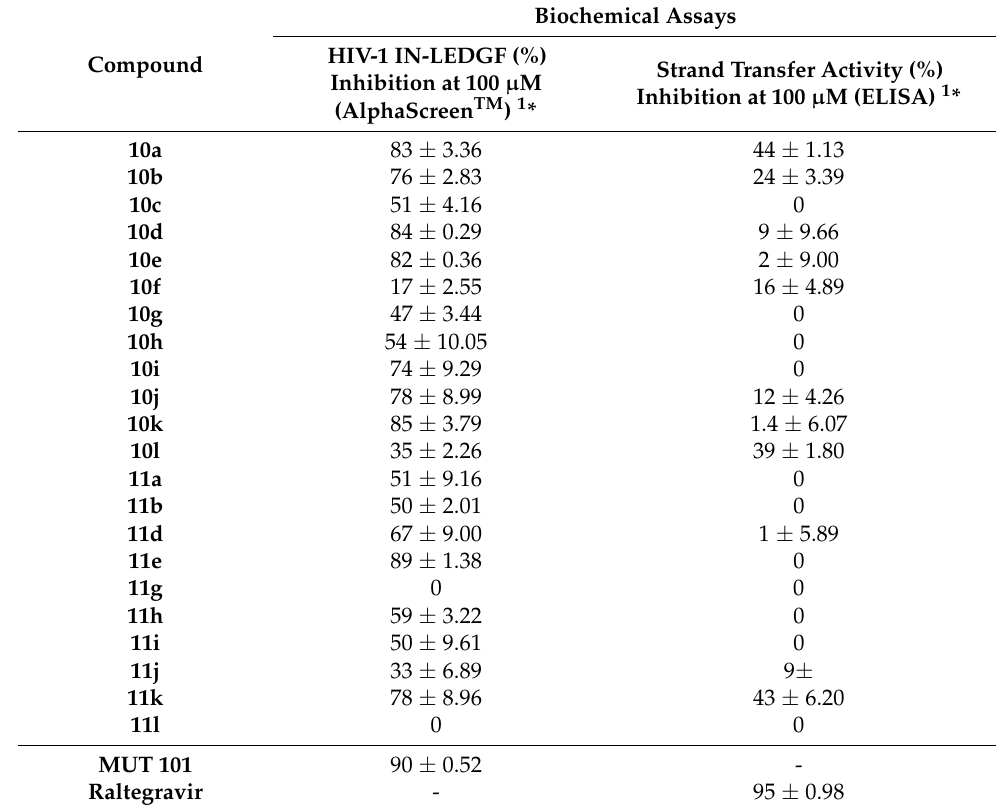
Table 3. The HIV-1 IN-LEDGF/p75 inhibition activities observed for 1,5-diaryl-1 H -imidazole-4-